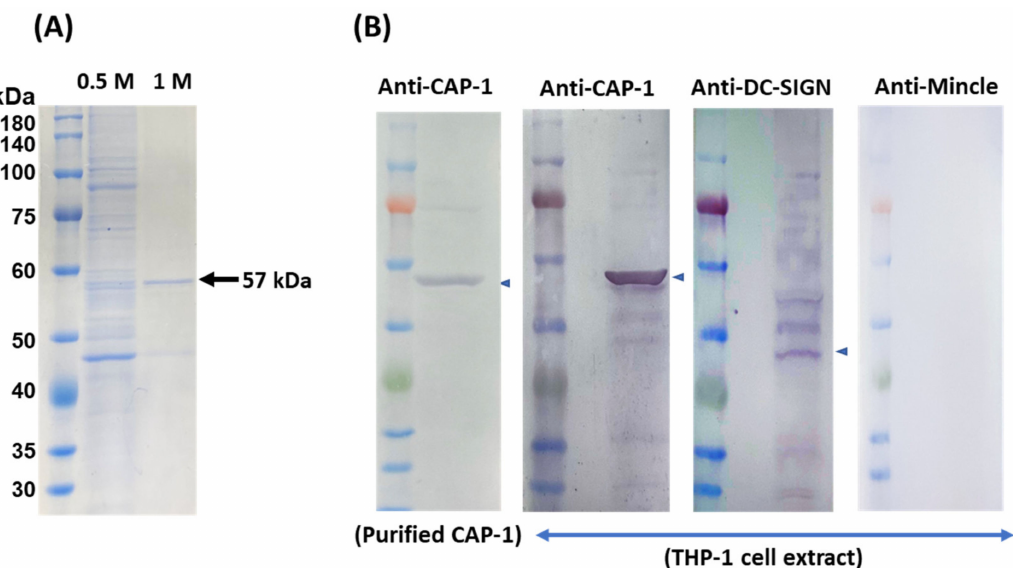
Figure 5. ( A ) SDS-10%PAGE of the affinity-purified 57 kDa receptor. ( B ) Western blotting analysis of affinity purified protein with anti-adenylyl cyclase-associated protein 1 (CAP-1) and crude ex- tract of THP-1 cells with anti-CAP-1, anti-DC-SIGN, and anti-macrophage-inducible C-type lectin (Mincle) antibodies.